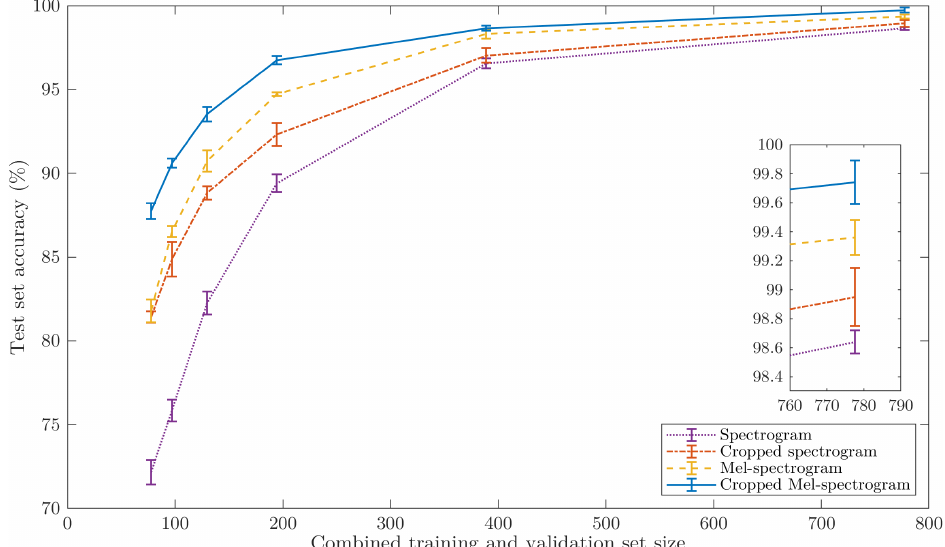
Figure 7. The accuracy and the associated standard deviations of the CNNs utilising the four data types as the combined size of the training and validation set is decreased. An expanded plot representing four data points is overlaid to the